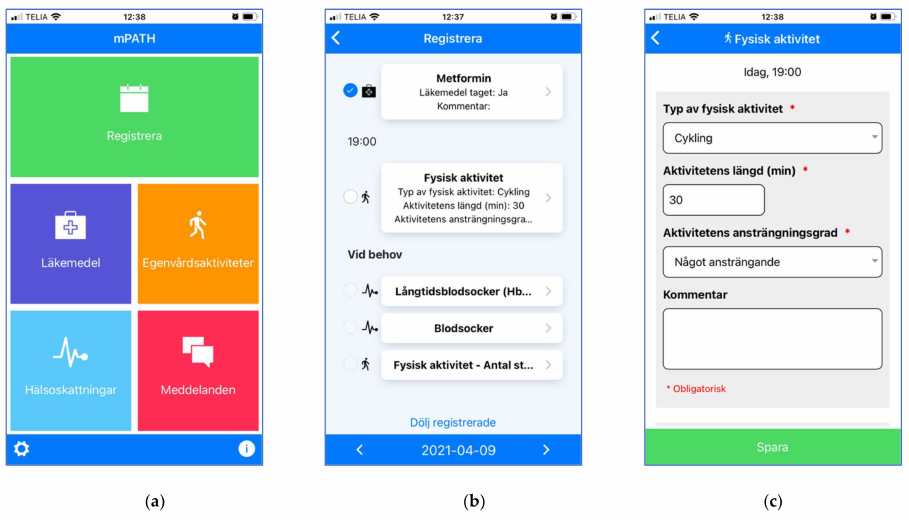
Figure 4. Screen prints of the mPATH app: ( a ) shows the mPATH home page that allows users to navigate to different pages: “Registrera” = Tracking, “Läkemedel” = Medications, “Egenvård- saktiviteter” = Self-management activities, “Hälsoskattningar“ = Health assessments, and “Med- delanden” = Messaging; ( b ) illustrates an example from the tracking page which lists all daily self-management tasks chronologically. If speed-tracking is possible (first two items in the list), default values are spelled out (“Läkemedel taget: Ja” = Medication taken: Yes) and users can simply click the checkbox to track the task as done; ( c ) illustrates the editing view where the user can edit details for individual self-management